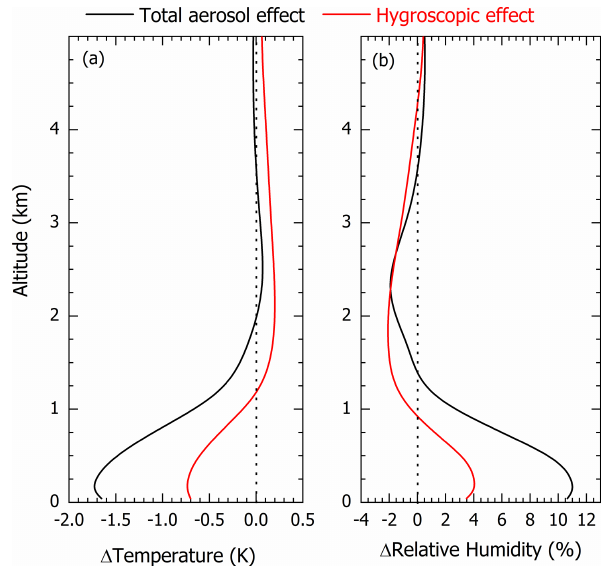
Figure 6. Vertical profiles of change in relative hu- midity and temperature due to the total aerosol effect (Ambient feedback − Ambient nofeedback ; black line) and only due to hygroscopic growth of aerosols (Ambient feedback − dry feedback ; red